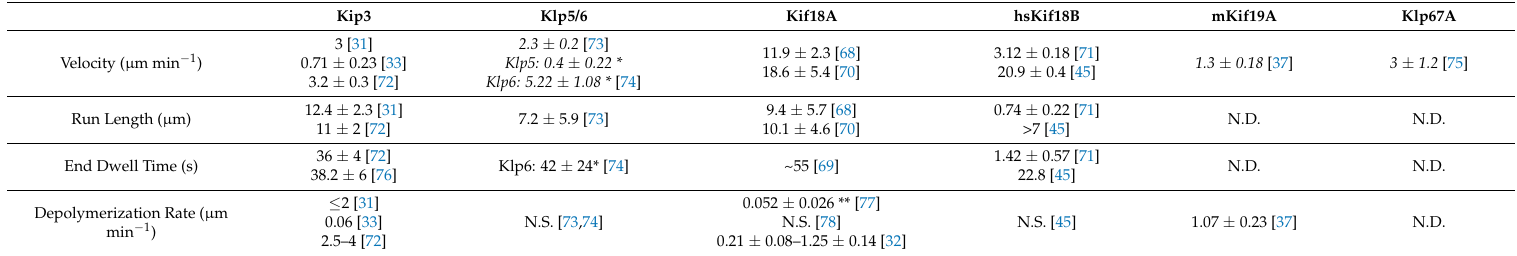
Table 2. Biophysical Properties of Kinesin-8